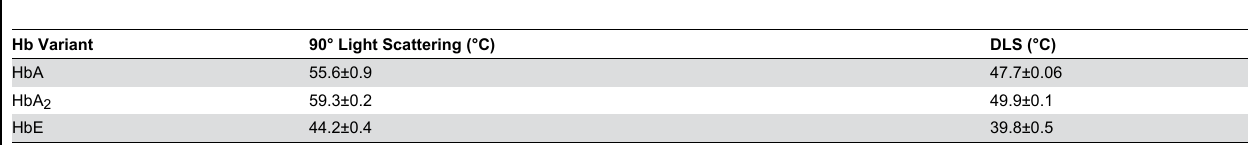
The error bars are Standard Errors of Mean (SEM) of 5 independent